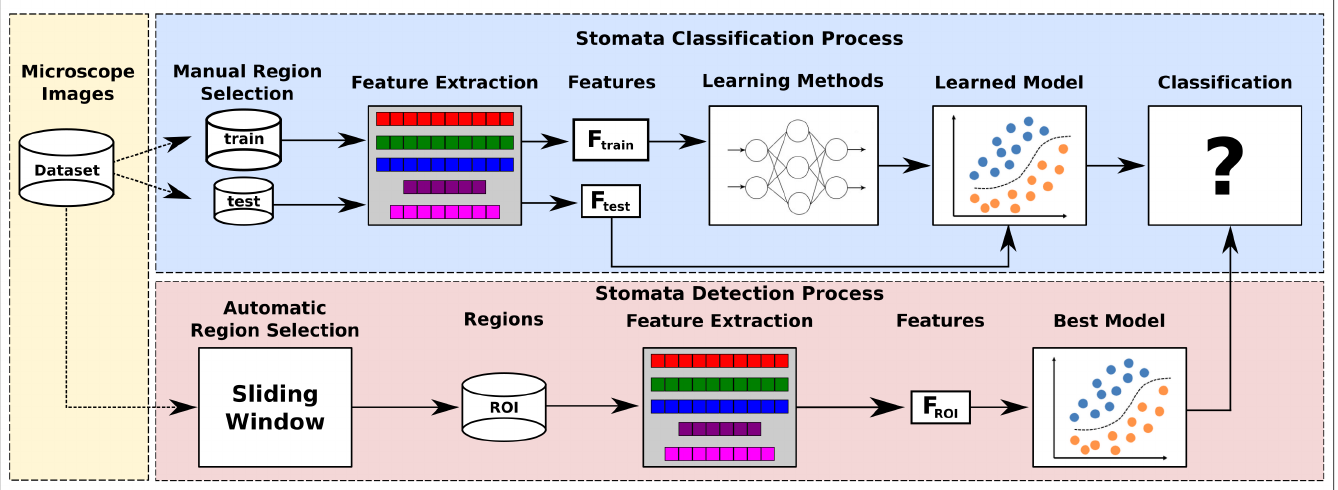
Fig 2. Schematic representation of the proposed pipeline for stomata classification and detection. The proposed approach comprises two main modules: (i) the stomata classification process, where a classification model based on machine learning is created and trained with features extracted from microscope images; and (ii) the stomata detection approach, combining a sliding window mechanism to separate a microscope image into sub-images and a stomata identification process using the model created in (i).